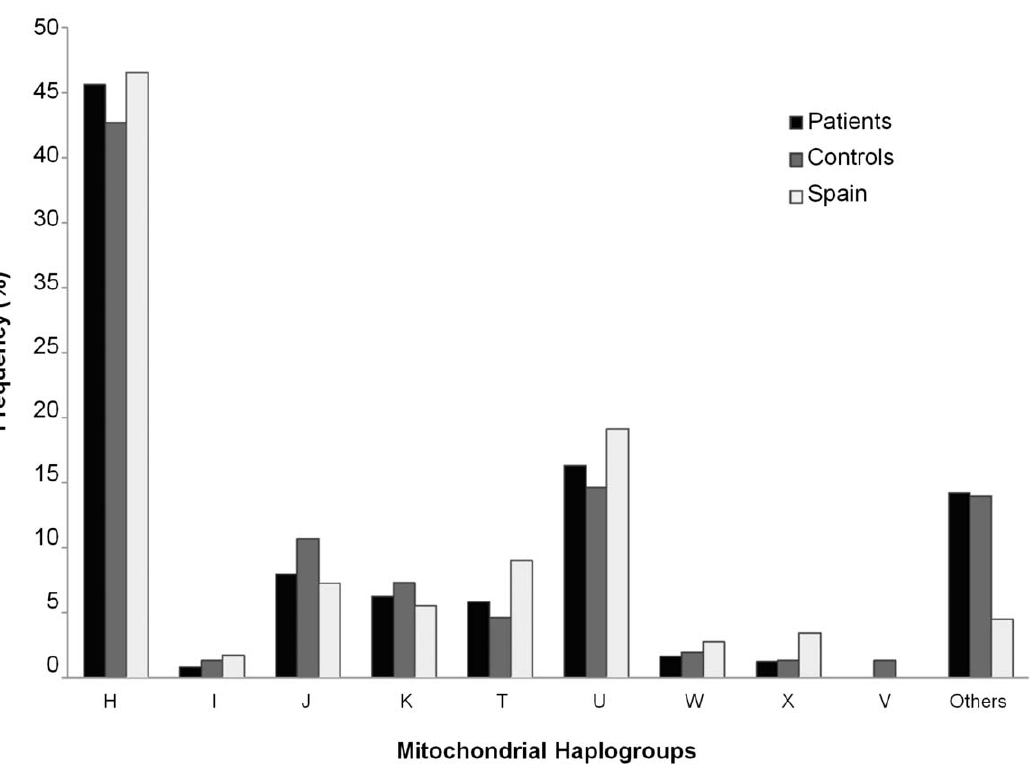
Figure 1. Bar graph representing the mitochondrial haplogroups in patients, controls, and the Spanish population.